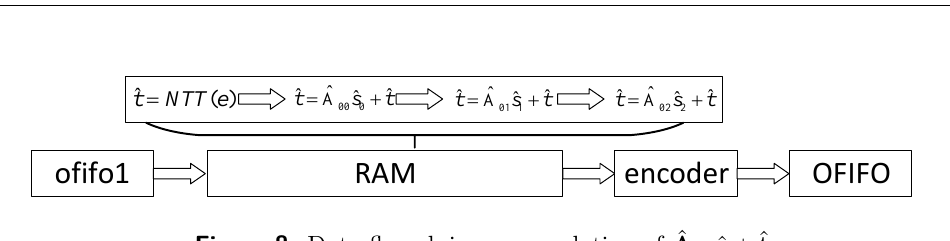
Figure 8: Data flow duing accumulation of ˆ A ◦ ˆ s + ˆ